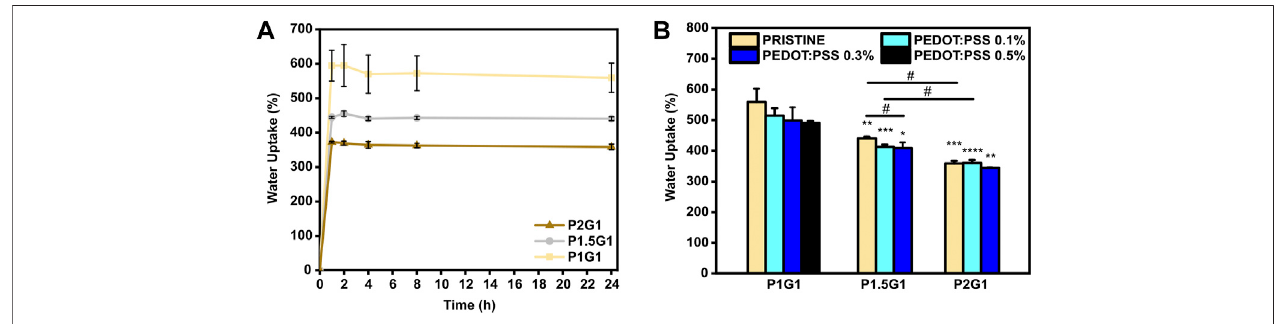
FIGURE3| Wateruptakeofhydrogels: (A) Behaviorofwateruptakepercentagevs.timeforpristinehydrogelsincubated for1,2,4,8and24 hinPBSat37 ° C. (B) Equilibrium water uptake percentage of hydrogels at 24 h * p < 0.05, ** p < 0.01, *** p < 0.001 and **** p < 0.0001 represent signi fi cative differences in respect to P1G1 samples. # p < 0.05 represent signi fi cative differences for all other